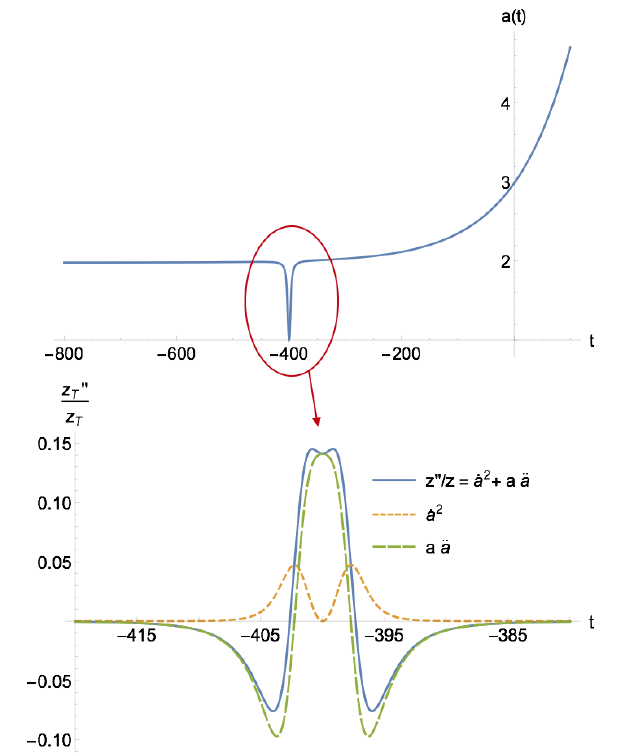
Figure 5. ( First panel ) Scale factor evolution with one bounce of negative sign characterized by C = 1, µ = − 400, σ = 2, and B = 0.4. ( Second panel ) Tensor potential around the bounce.